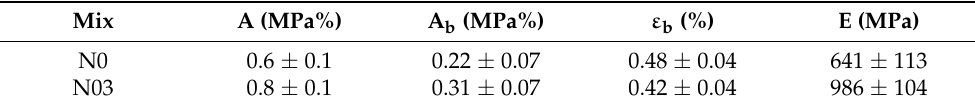
strain (%) relation, area (A b ) after the break point ( ε b ) and flexural modulus (E) of mortars with 0%